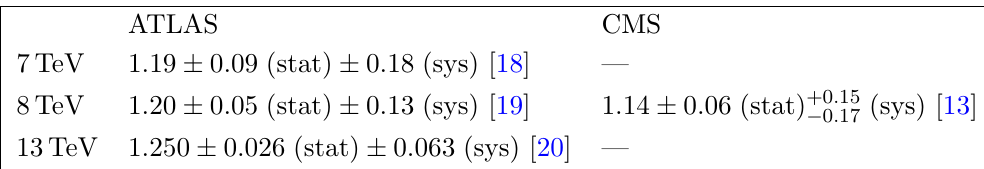
Table 2 . Measurements of the best-(cid:12)t parameter f SM in (1.3) in the t (cid:22) t dilepton decay mode by the ATLAS and CMS